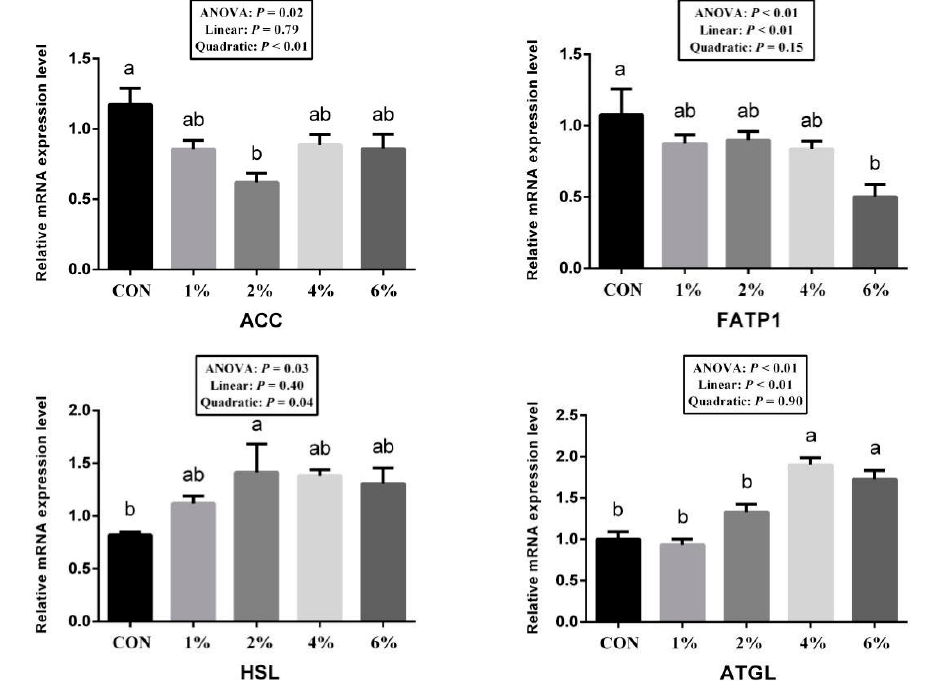
Figure 1. Diet supplement tea powder inhibited fat synthesis and promoted fat catabolism in longissimus dorsi muscle. The relative mRNA expression levels of the key genes related to lipid metabolism include acetyl-CoA carboxylase α (ACC), fatty acid transport protein 1 (FATP1), hormone-sensitive lipase (HSL), adipose triglyceride lipase (ATGL) ( n = 6). Duncan, linear and quadratic effects for tea powder inclusion levels. Data are expressed as means ± SEM; ab different superscripts indicate significant differences ( p <